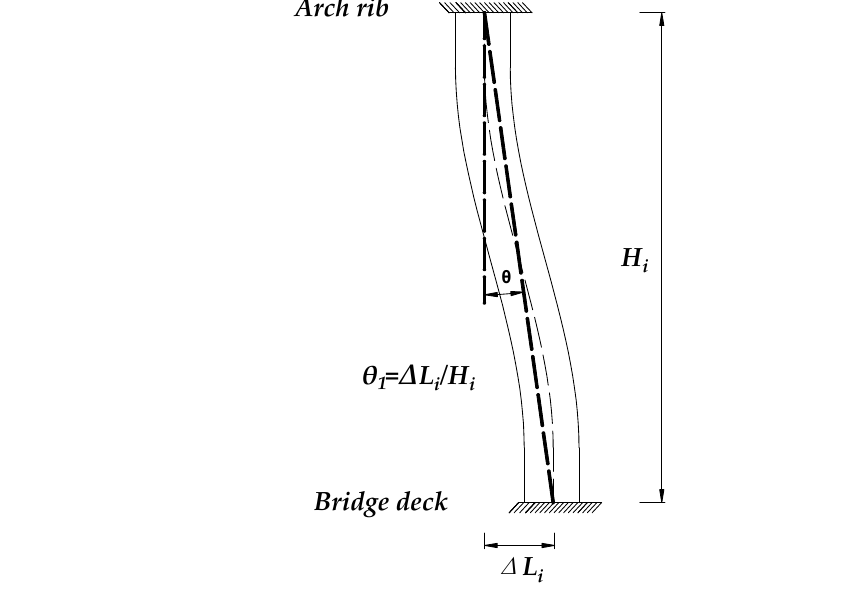
Figure 6. Lateral bending deformation of the hangers under the longitudinal deformation of bridge decks.